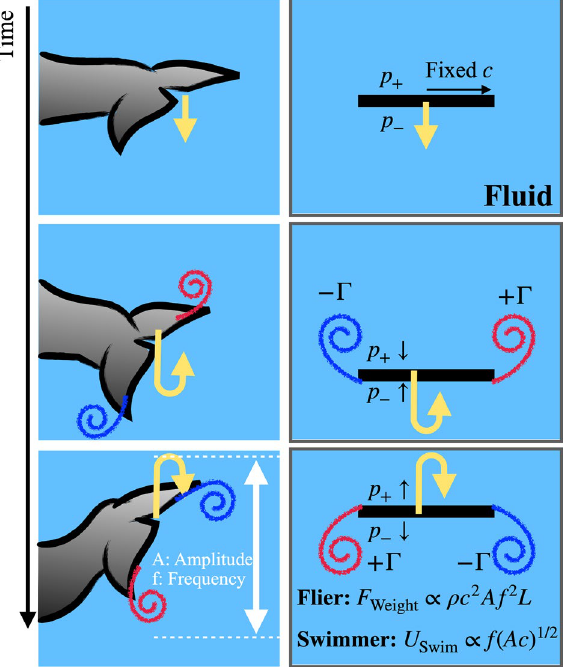
Figure 6. Schematic of motion sequences of a swimming animal and a corresponding thin plate model. For fliers, we predict that the weight balances with thrust force. For swimmers, the swimming speed is predicted.